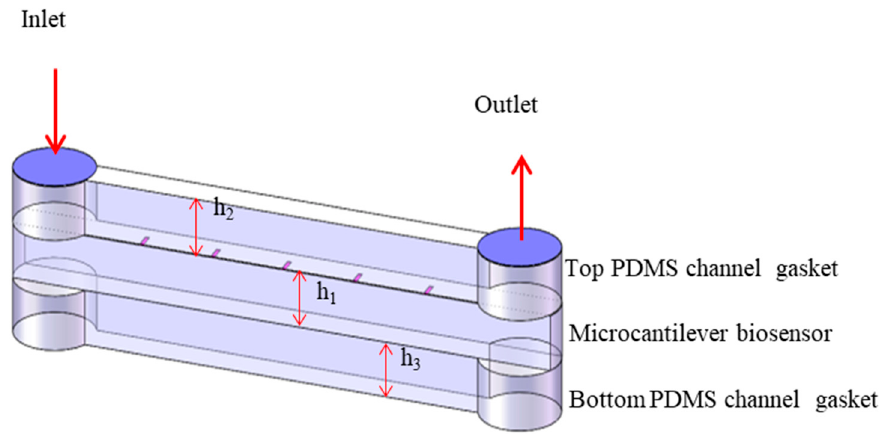
Sensors 2019 , 19 , x FOR PEER REVIEW Figure 3. Schematic of microfluidic platform reaction chamber.